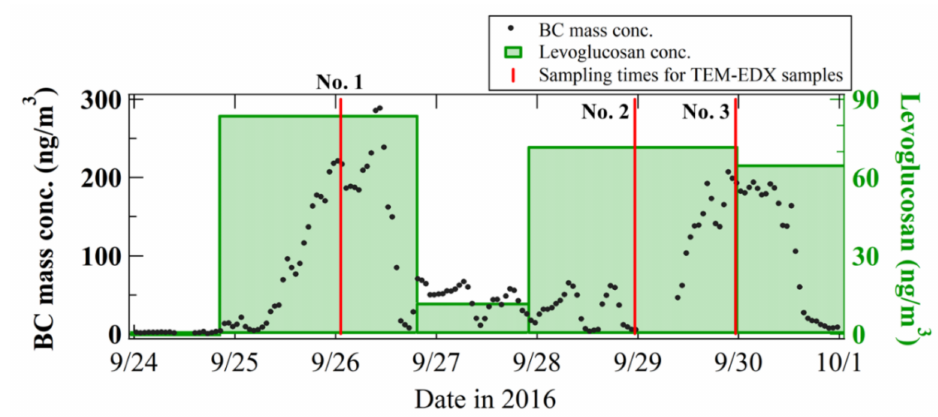
Figure 2. The concentrations of BC mass (1 h average) and levoglucosan. Red lines show the sampling times for the TEM-EDX samples.